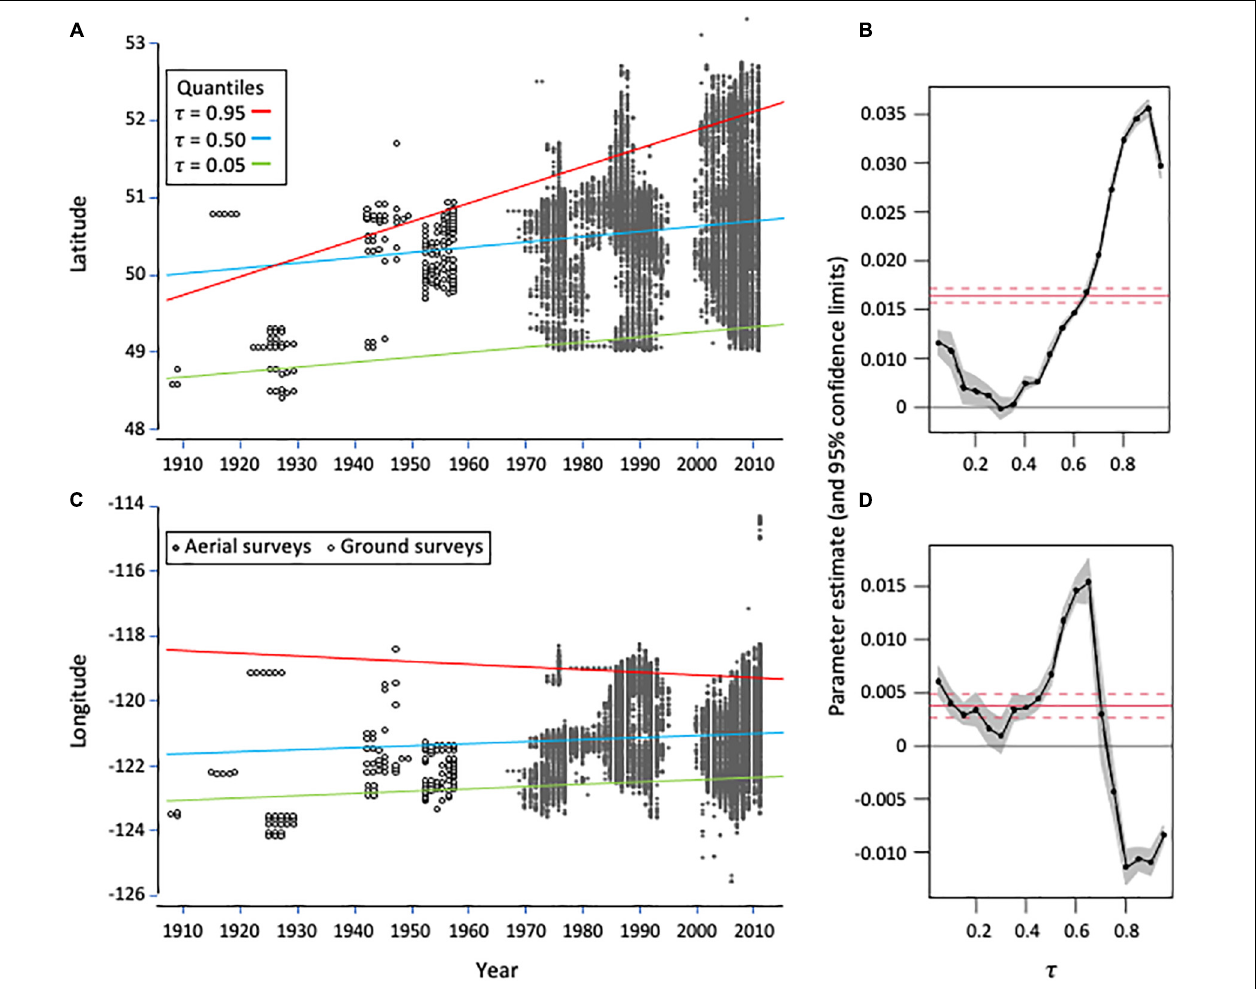
FIGURE 2 | Quantile regression analyses examining the relationships between year and (A) latitude and (C) longitude of outbreak infestation centroids of the western spruce budworm, Choristoneura freemani , in British Columbia (BC), Canada from 1909 to 2011. Regressions were fit to the 5th ( τ = 0.05), median ( τ = 0.50) and 95th ( τ = 0.95) quantiles. Estimates of the slope of the quantile linear regressions for latitude (B) and longitude (D) as a function of τ (black line, 95% confidence intervals in gray) are also presented. The ordinary least squares coefficients are shown in panels (B,D) as solid red lines with their confidence intervals as dotted lines. The location of infestations was determined by ground observations from 1909 to 1960 and from aerial surveys thereafter. Data were provided by the BC Ministry of Forests, Lands, Natural Resource Operations and Rural Development.